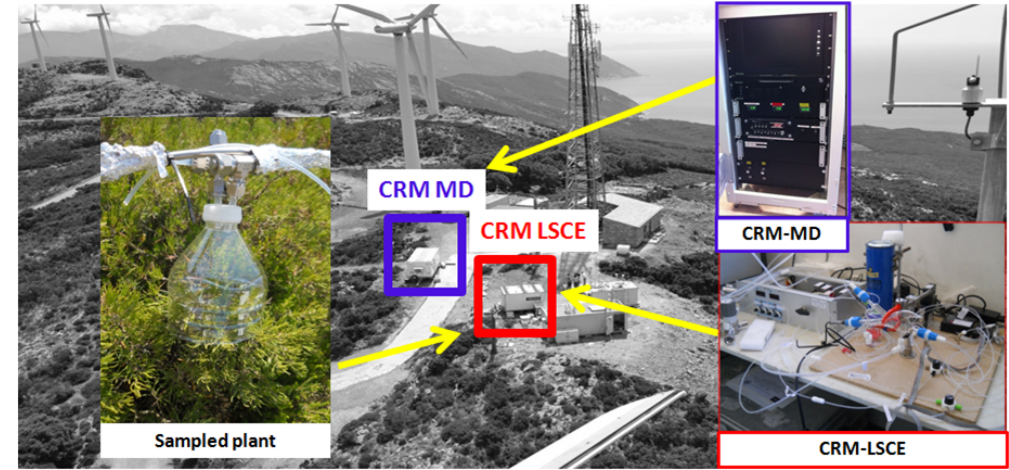
Figure 4. Top view of the field site at Cape Corsica. Relative distances between the trailers containing the instruments, details of the instruments and sampled plant species are provided.